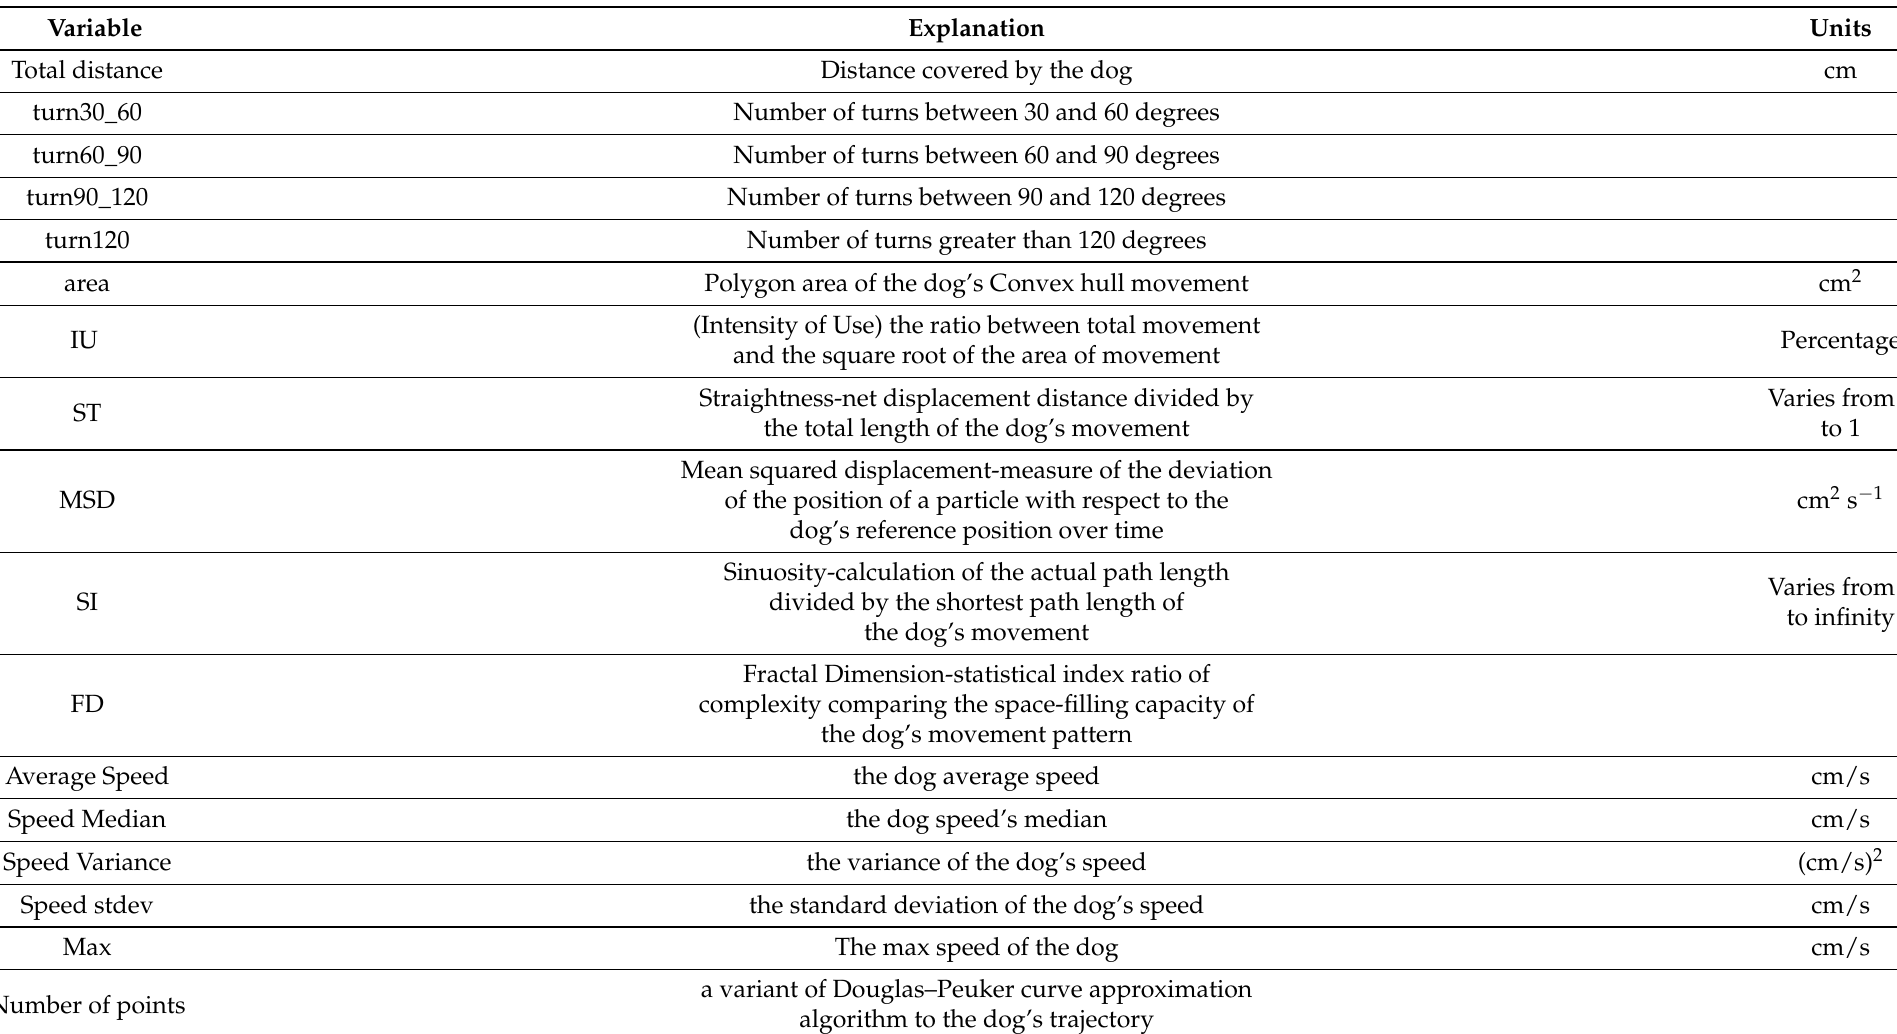
Table A3. Summary of potential